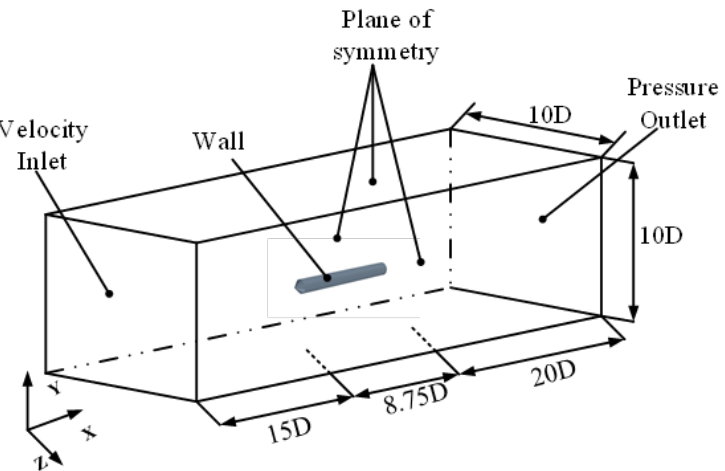
Figure 2. Experimental setup and computational geometric model.